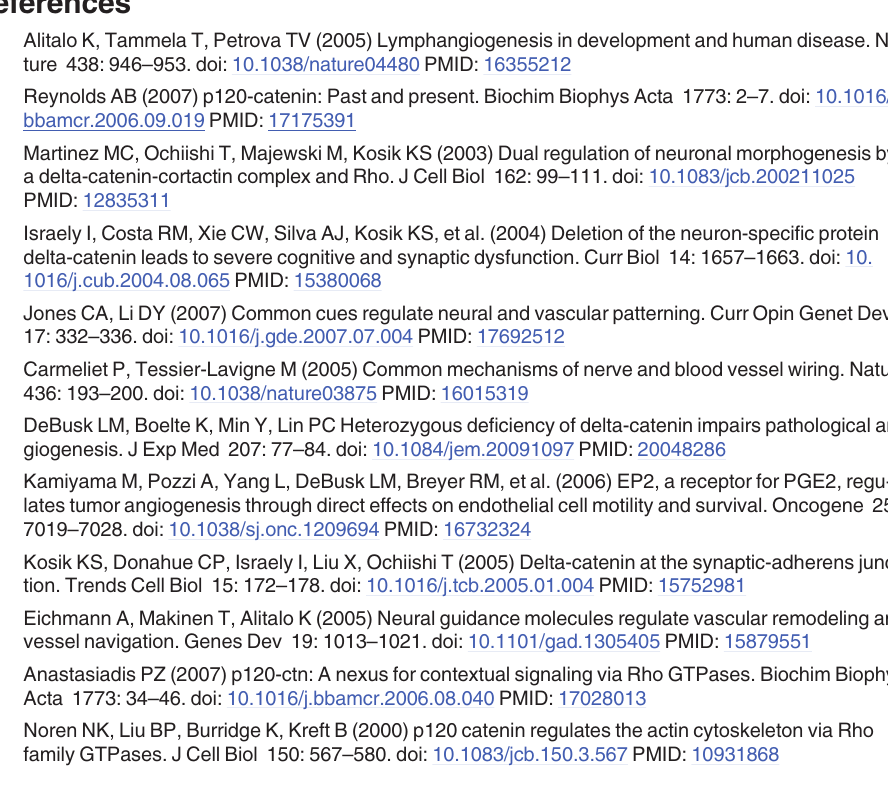
Figure 4. Loss of δ -catenin impairs lymphangiogenesis and tumor growth in an experimental metastasis mouse model. 3LL cells (1x10 5 ) were injected into tail vein of wild type littermates and δ -catenin null mice. Two weeks after the injection, lungs were excised from mice and images were taken (Panel A). Arrows point to tumor metastases in lungs. Lung weight (Panel B) and lung surface metastases (Panel C) were quantified and graphed. * p < 0.05. Tumor metastases were sectioned and stained with an antibody against Lyve-1 (Panel D). Lyve-1 positive vascular structures were counted in 10 randomly selected high power fields under microscopy and graphed (Panel E). * p < 0.05. Representative images were shown. This experiment was repeated twice and each time 5 mice per group were